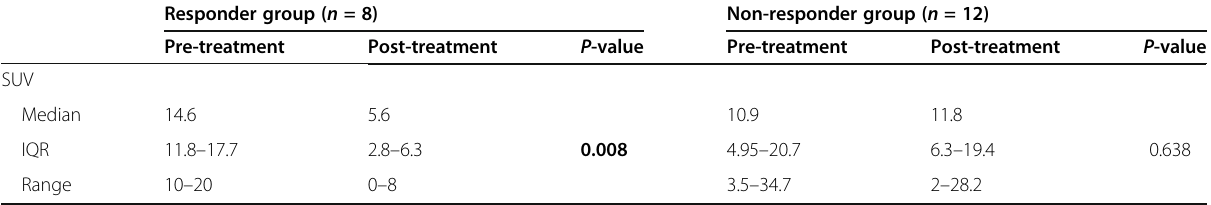
Table 2 Comparison of baseline and post-treatment SUV in both responder and non-responder groups Responder group ( n = 8)